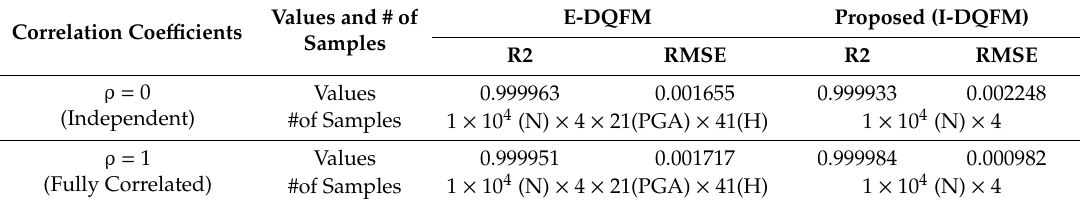
Table 2. Comparison results of R2 and RMSE of a multi-hazard system fragility curve obtained from the E-DQFM and the proposed method on example “C1 ∩ C2”.